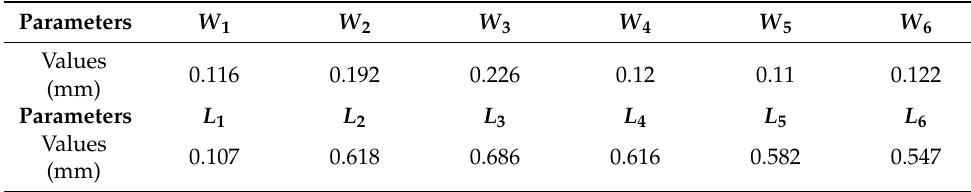
Table 6. Optimized dimensions of the type-2 crossover.